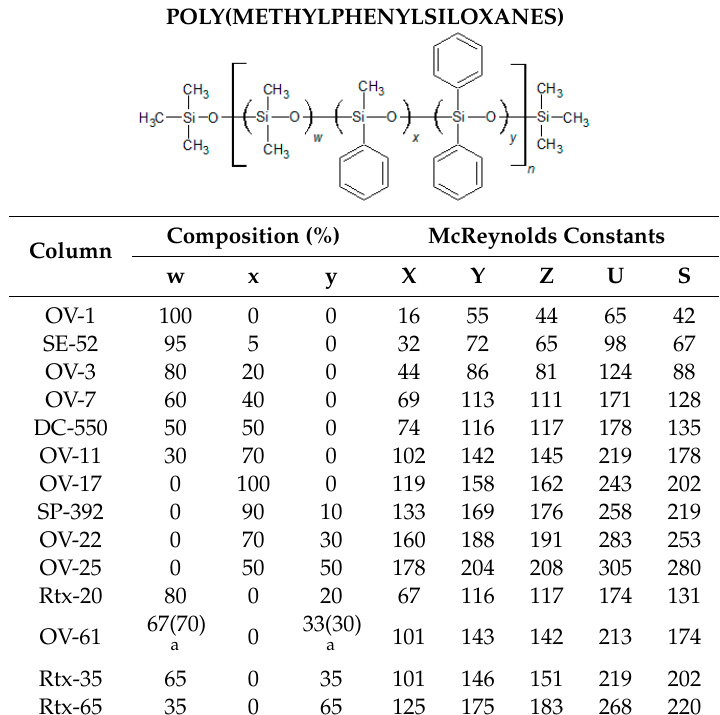
Table 1. Molecular structure of poly(methylphenylsiloxane) stationary phases and related McReynolds constants.